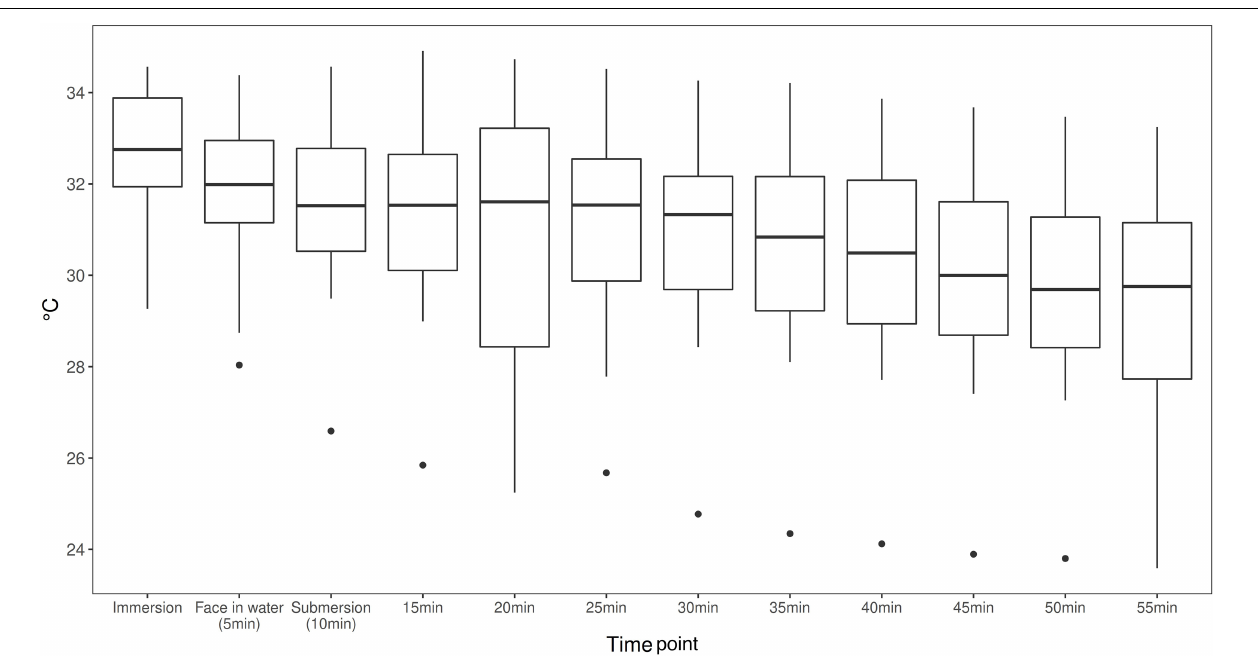
Area weighted skin temperature (Tskin) was calculated from the skin temperature measures with the ISO Standard weighting coefficients at 5-min intervals